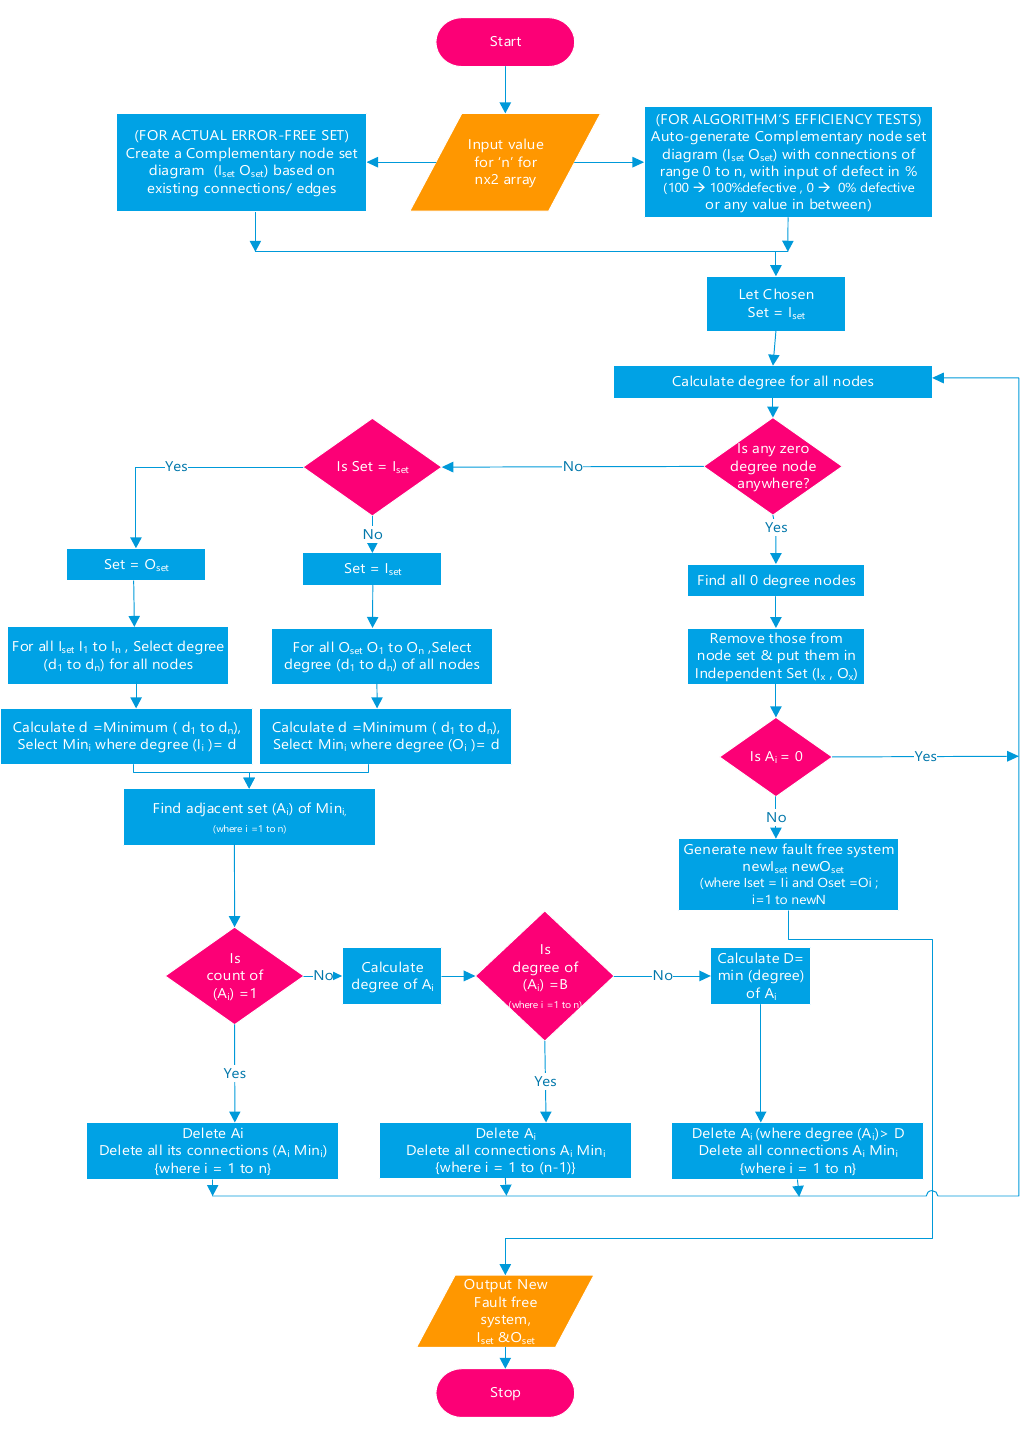
Figure 3. Flowchart of the novel defect-tolerant scheme.